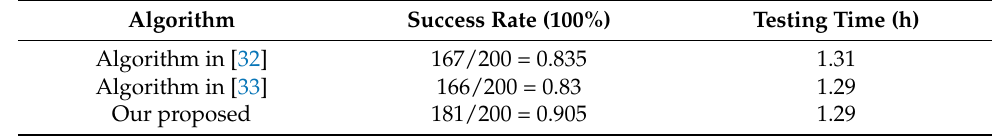
Table 12. Comparison of test results of each algorithm in simulation Figure